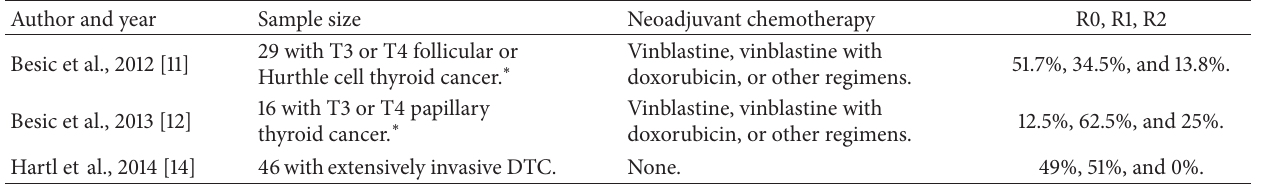
Table 3: Rates of residual tumor after resection in differentiated thyroid